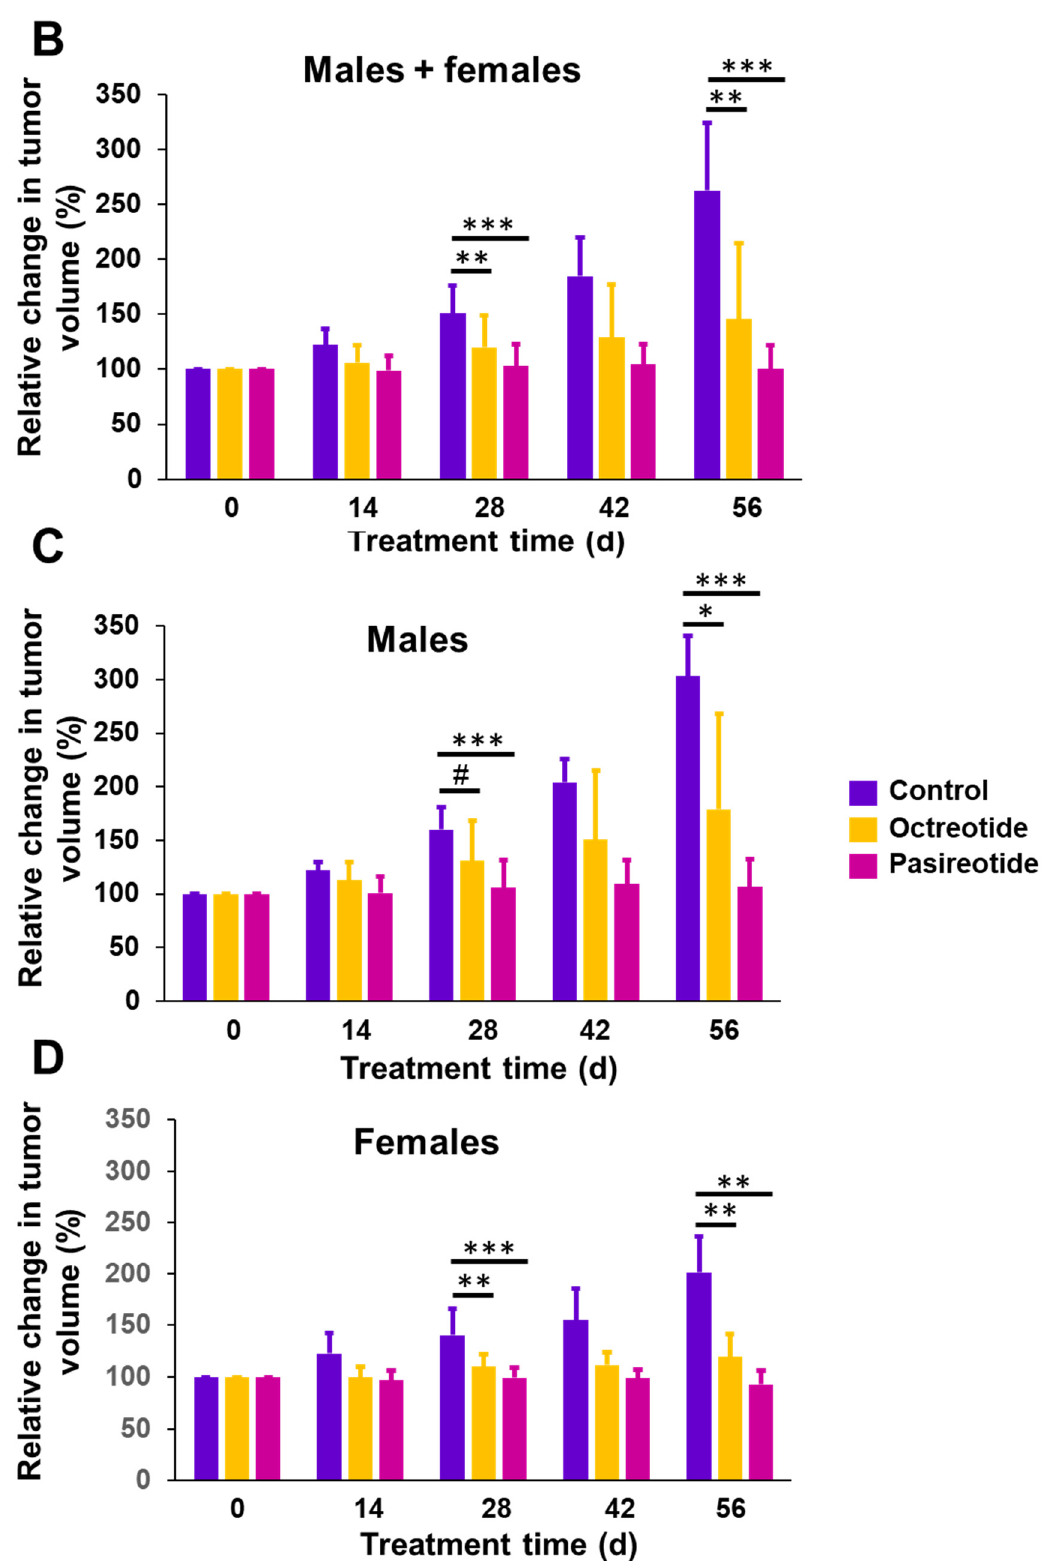
Figure 1. Head-to-head in vivo evaluation of octreotide LAR (sandostatin ® ) and pasireotide LAR (signifor ® ). ( A ) Treatment scheme. MENX-affected rats at the age of 5.5 months were injected with sandostatin ® and signifor ® 1 × or 2 × every 28 days at the indicated dose. MRI was performed every 14 days. At the end of treatment, animals were sacrificed, and tissues were collected for histological and molecular analyses. ( B – D ) Relative changes in tumor volume as measured by MRI.